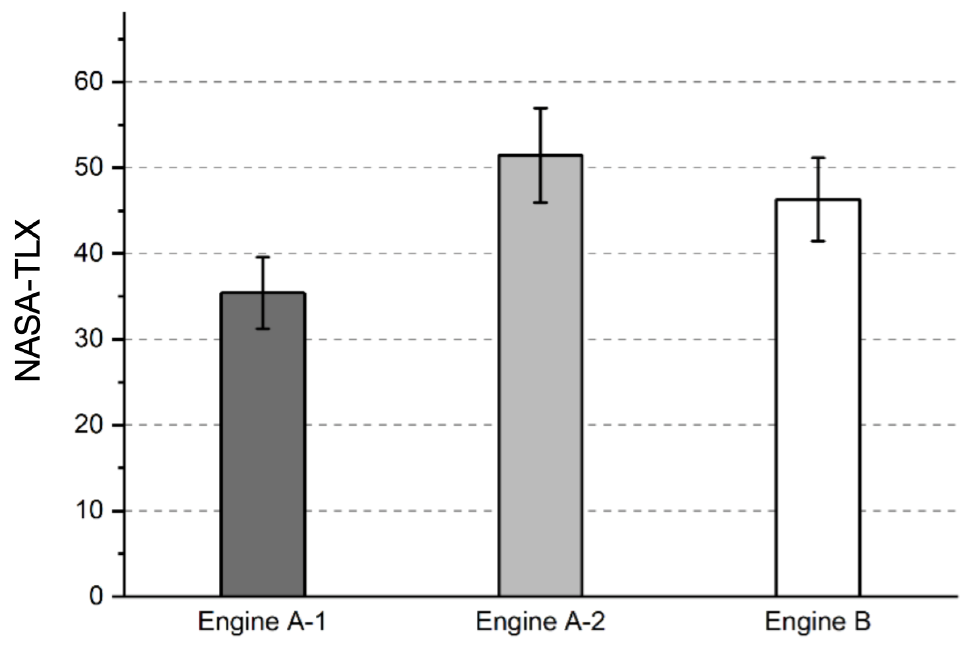
Figure 38. Weighted average score of NASA-TLX workload in engine maintenance task.